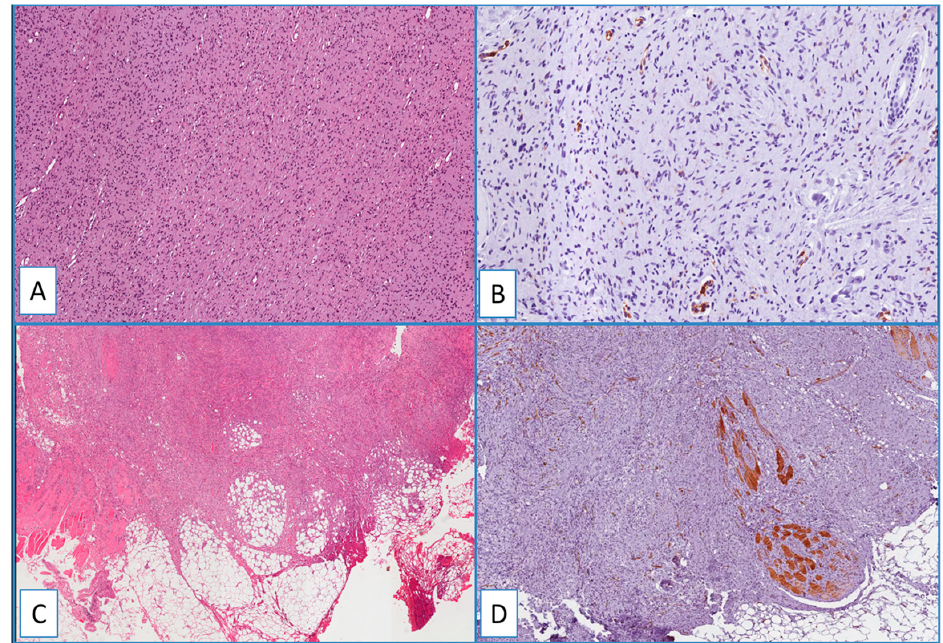
Figure 4. ( A ) Typical nodular dermal neurofibroma (H&E; original magnification 100×), showing a heterogeneous/focal and weak positivity for WT1; ( B ) (immunoperoxidase; original magnification 150×); ( C ) low magnification showing morphological details of a deep fibrous histiocytoma, containing foci of skeletal muscle infiltration (H&E; original magnification 50×); immunohistochemical analysis showed no detectable staining for WT1 in the neoplastic cells; ( D ) cytoplasmic staining of blood vessels and skeletal muscle cells (immunoperoxidase; original magnification 50×). WT1 was detected in the cytoplasm of endothelial cells of intra ‐ and extra ‐ tumoral blood vessels, and this staining served as an internal control.